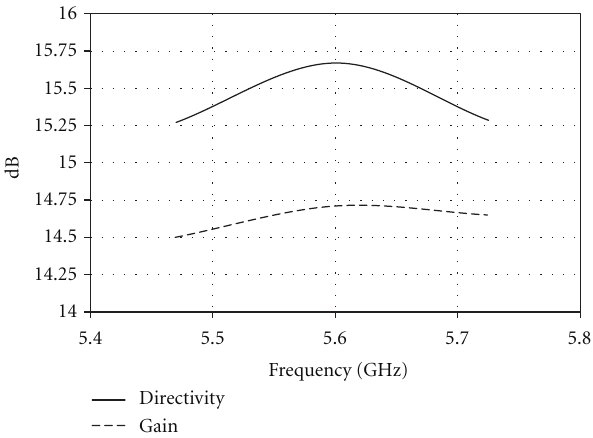
Figure 11: Directivity and gain versus the frequency ( θ = 75 ◦ , ϕ = 90 ◦ ).